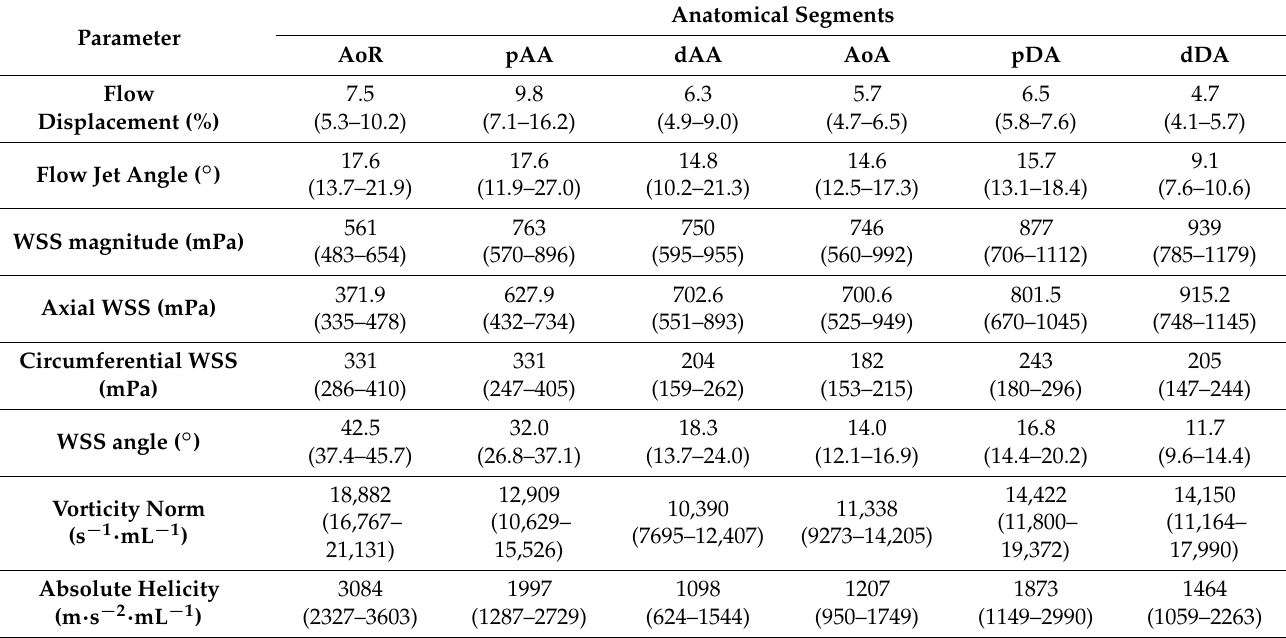
Table 2. The hemodynamic and morphologic characteristics assessed in the thoracic